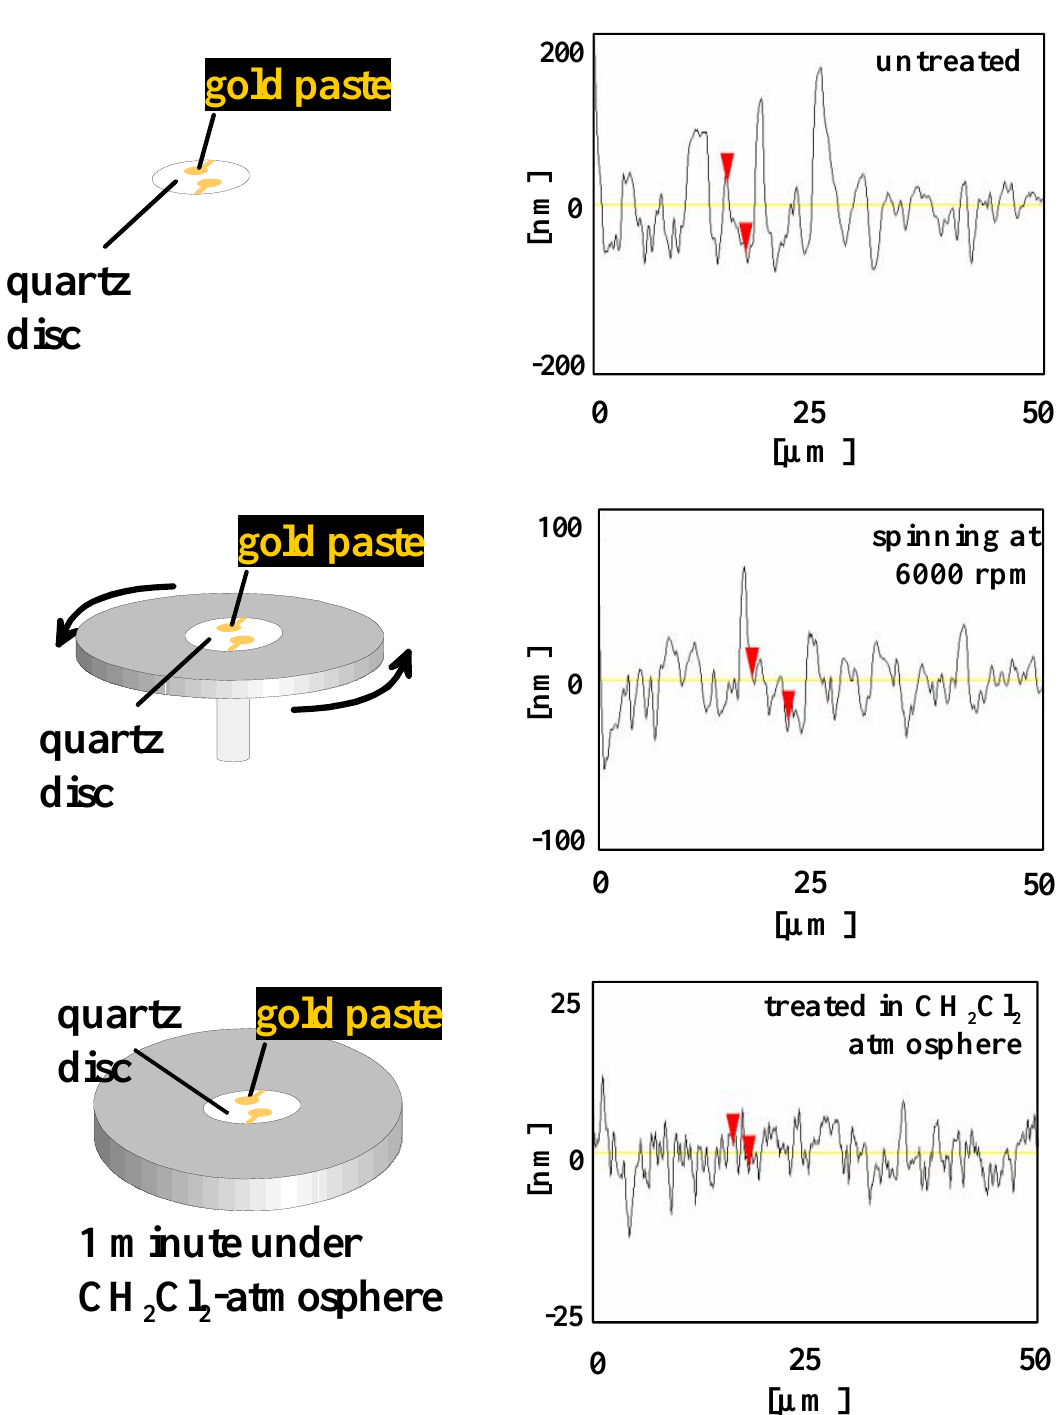
Fig. 2 Influence of electrode pre-treatment on the electronic